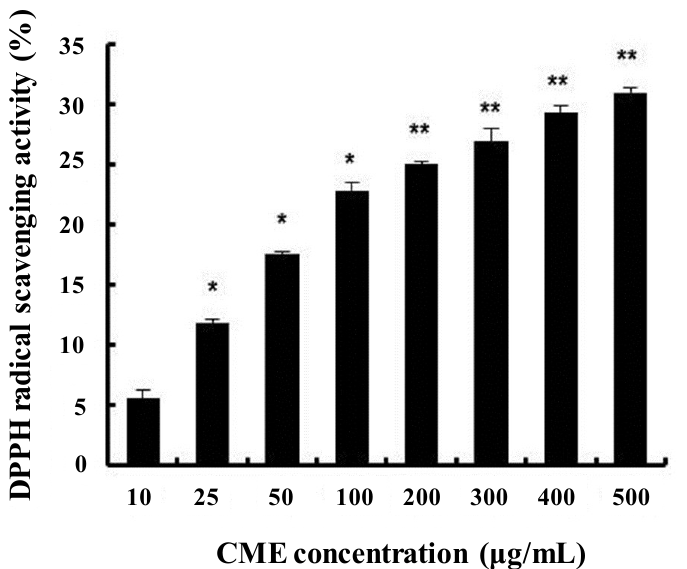
Figure 1. DPPH radical scavenging activity of Cordyceps militaris extract (CME). The amount of DPPH radicals was determined spectrophotometrically at 520 nm. Data represent the mean ± SE of three independent experiments. Significance of the differences were compared with the non-treated group at * p <